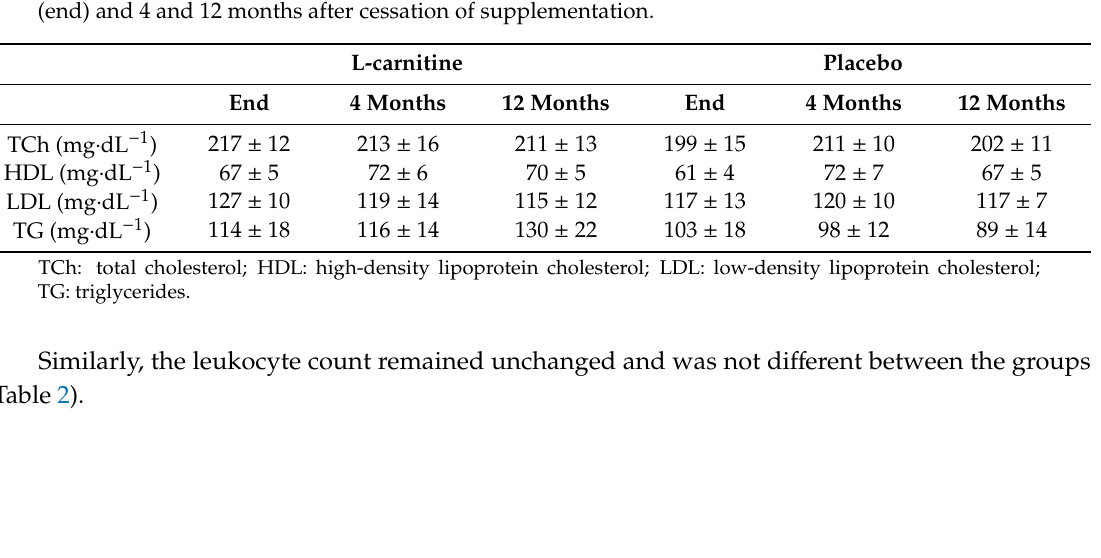
Table 1. Serum lipid metabolites in L-carnitine and placebo groups after 24 weeks of supplementation (end) and 4 and 12 months after cessation of supplementation.